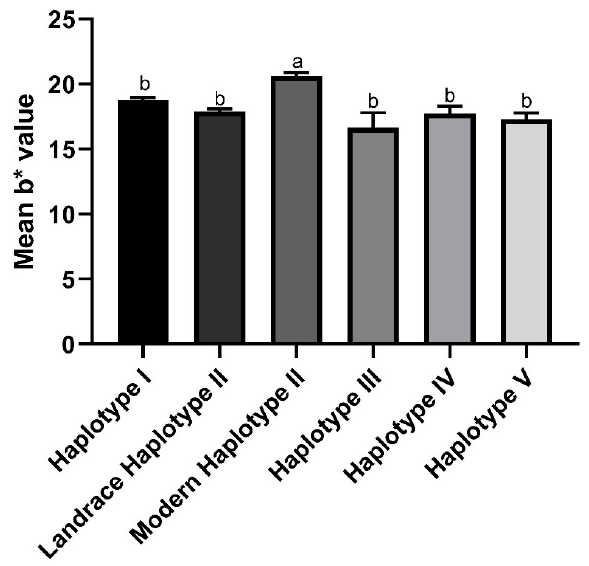
Figure 2. Lpx-B1 haplotype b* values. Genotypes from the Mediterranean panel were grouped according to their Lpx-B1 haplotype and a distinction was made between modern cultivars and landraces. One-way ANOVA and Tukey’s post hoc test were performed to find significant differences ( p < 0.05).